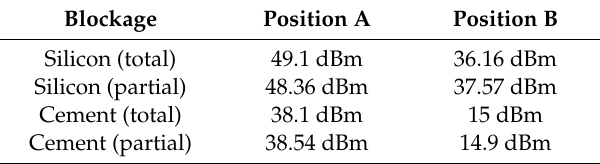
Table 3. Amplitude of the filtered signal (in dBm) for different types of blockage and different positions of the receiver.